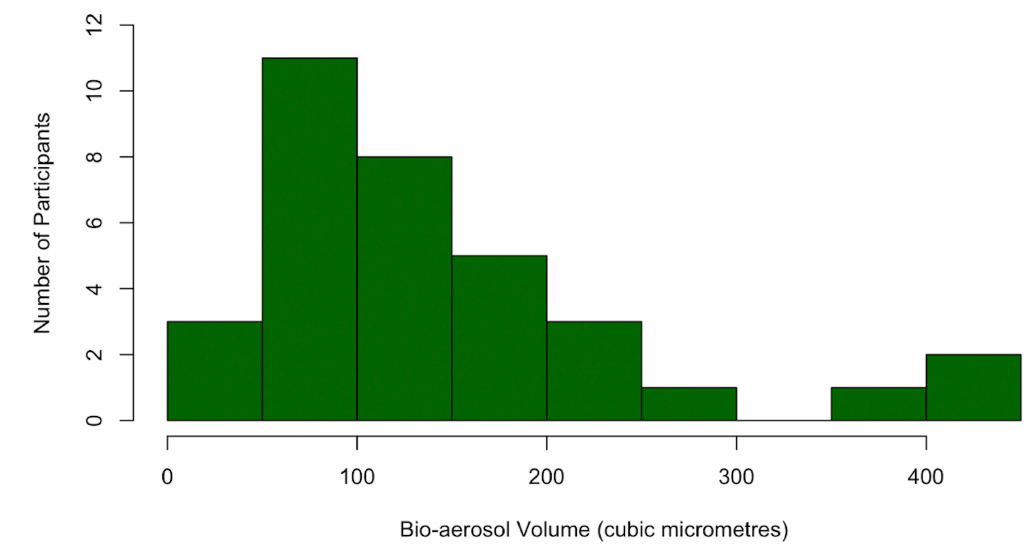
Figure 3. Histogram of bio-aerosol volume per litre of exhaled air for RASC